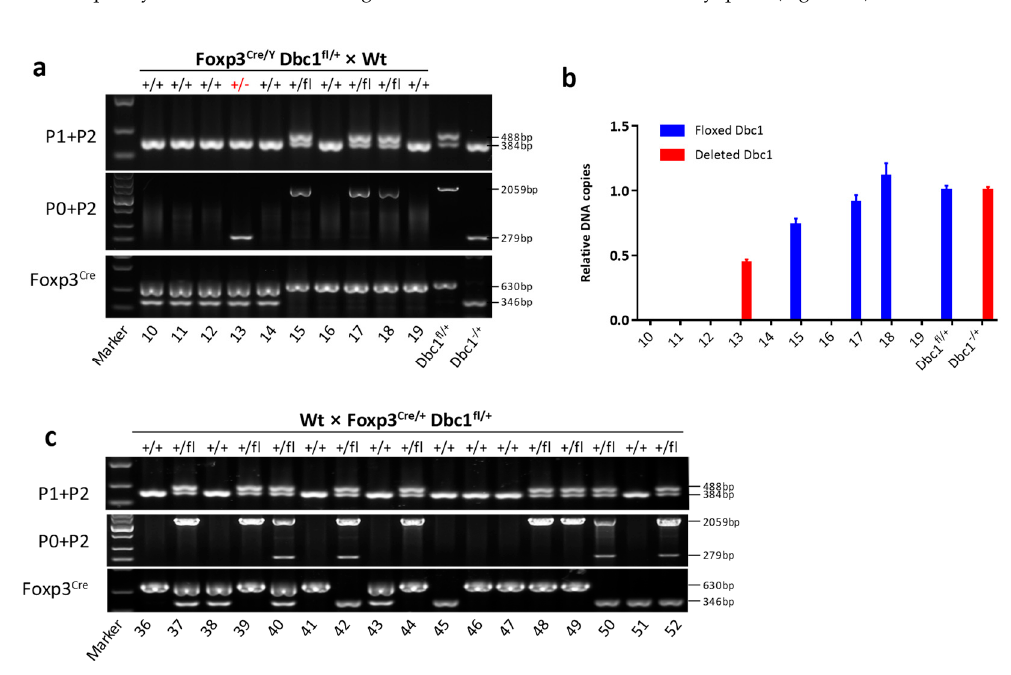
Figure 3. The mice with deleted Dbc1 allele was present in the progeny of male Foxp3 Cre/Y Dbc1 fl/+ mice. ( a ) The PCR product sizes of the progeny of male Foxp3 Cre/Y Dbc1 fl/+ mice crossing Wt female mice using the primer indicated. ( b ) The relative amount of the floxed Dbc1 and recombined Dbc1 of the mice in ( a ) was tested by qPCR. For qPCR, the results were normalized to the DNA sample from Dbc1 fl/+ mice or mouse #4 in Figure 2a. The data were represented as the mean ± standard deviation of three independent experiments. ( c ) The PCR product sizes of the progeny of female Foxp3 Cre/+ Dbc1 fl/+ mice crossed with Wt male mice using the primer indicated. The panel of Foxp3 Cre shows the genotype of Foxp3 -IRES-YFP-Cre alleles. +/ − , +/+, and +/fl show the genotype of Dbc1 alleles. Table 1. Frequency of mice with deleted Dbc1 allele in the progeny of different breeding pairs. Breeding mice